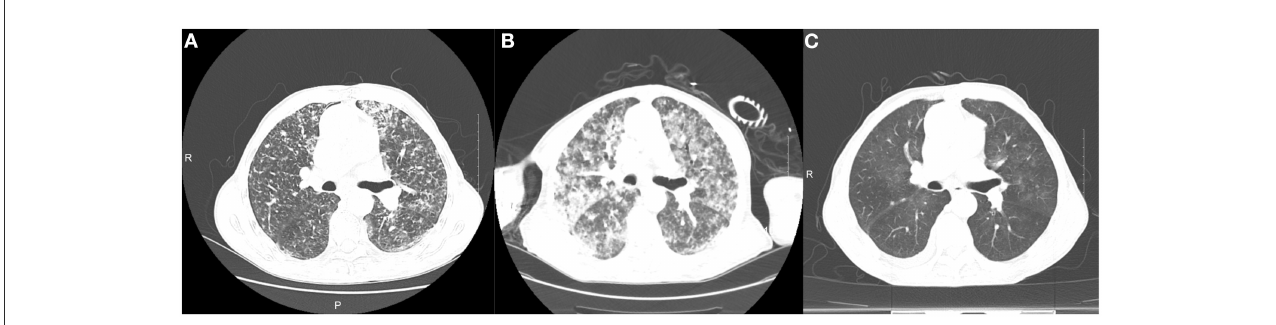
FIGURE1 Computed tomography findings. Computed tomography images were respectively taken on admission (A) , after intravenous piperacillin tazobactam (B) , and before discharge (C)